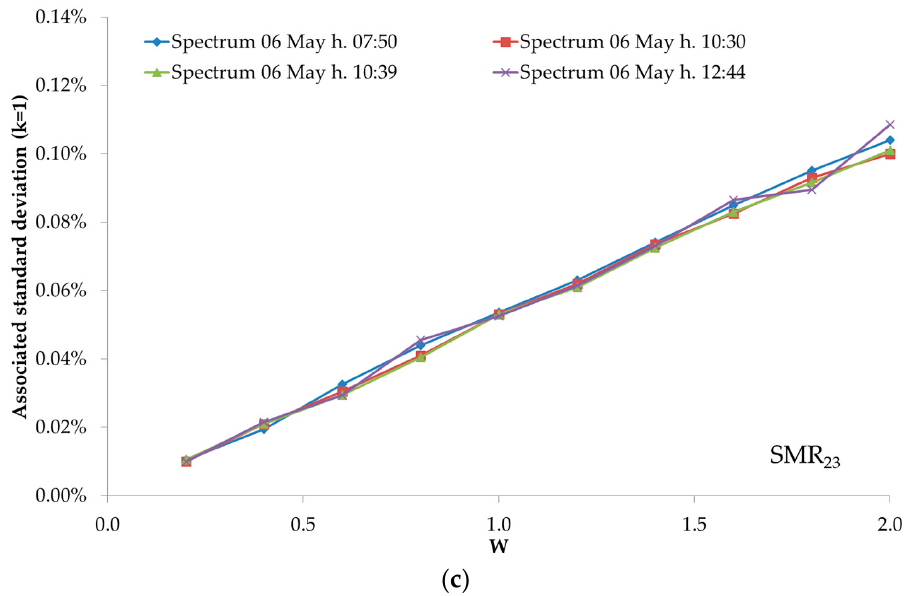
Figure 7. Impact of random errors of measured spectrum on the three SMR. The linearity of the functions is notable, and the slopes indicate that the spectral random errors have the same impact on all the three SMR. ( a ) case of SMR 12 ; ( b ) case of SMR 13 ; ( c ) case of SMR 23 .